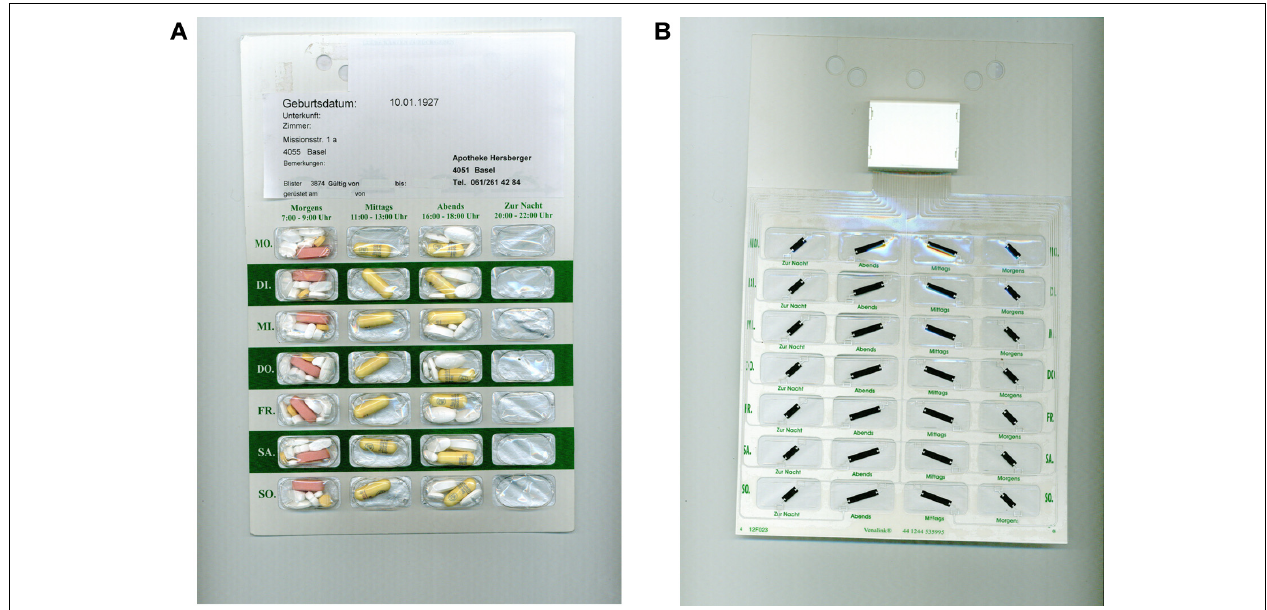
FIGURE 1 | (A) Front side of a commercially available multidose punch card (Pharmis GmbH, Beinwil am See, Switzerland) with 7 × 4 cavities pre-filled with a patient’s individualized medication regimen. (B) Rear side covered with an electronic film of conductive tracks, a battery and an antenna, and a microchip housing (Confrérie Clinique S.A., Lausanne,